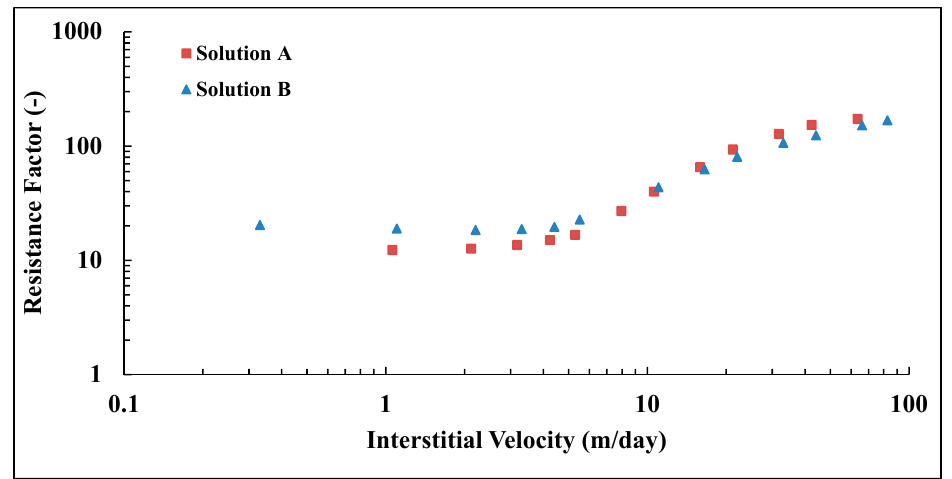
Figure 12. Influence of pre-shearing on Solution A (MW = 18 MDa) compared to pre-filtered Solution B (MW = 12 MDa).